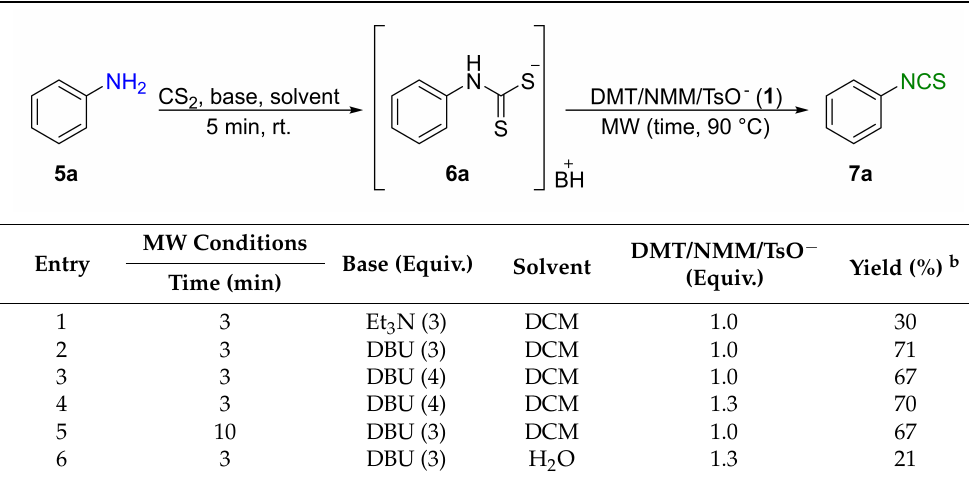
Table 2. Optimization of reaction conditions of synthesis of isothiocyanate 7a , derived from model amine 5a a